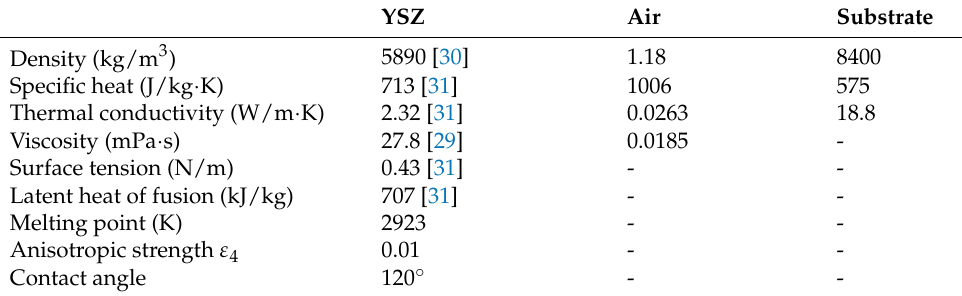
Table 1. Thermophysical quantities used in simulations.